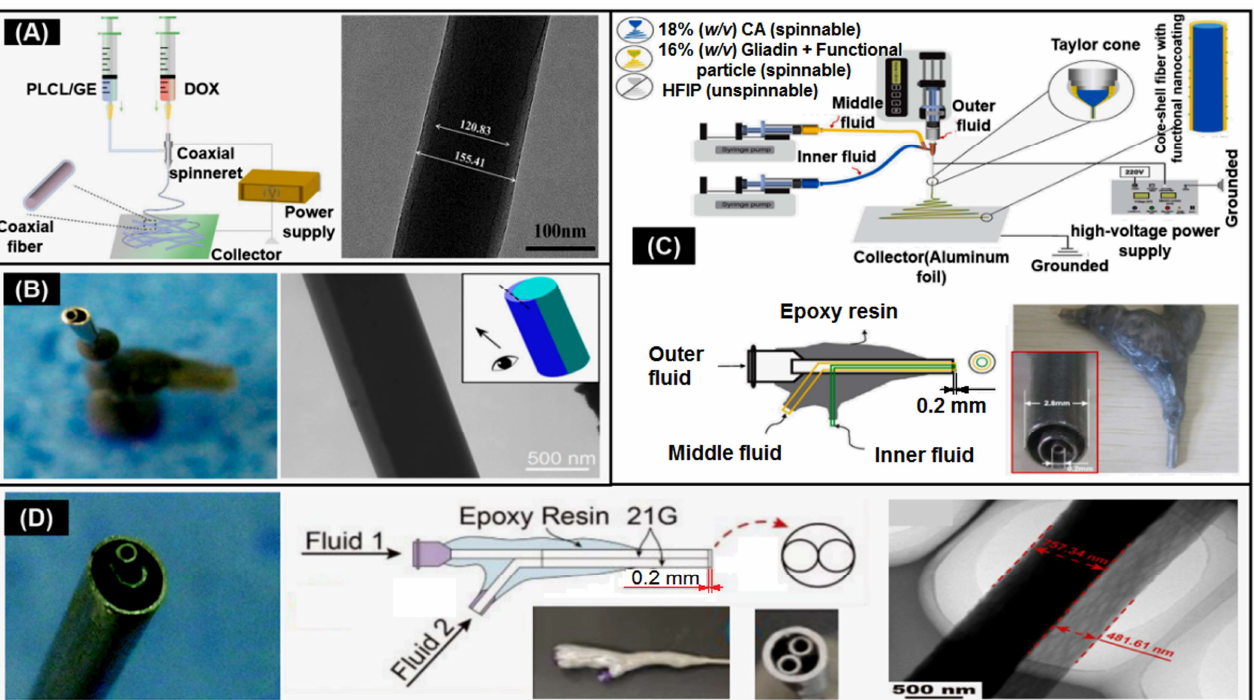
Figure 5. Electrospinning process for fabrication of complex structured nanofibers. ( A ) Two-fluid